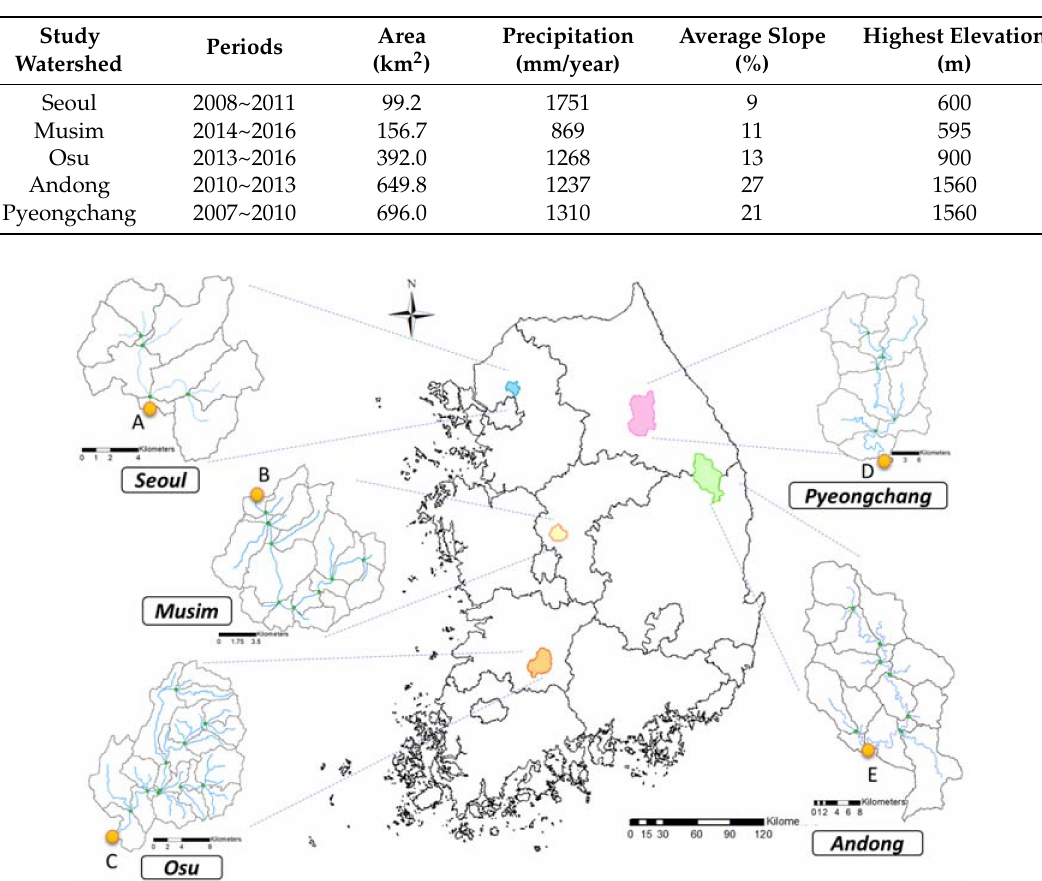
Figure 1. Locations of the five study watersheds (Seoul, Musim, Osu, Pyeongchang, Andong) in South Korea. Symbols and letters denote the locations of streamflow measurement